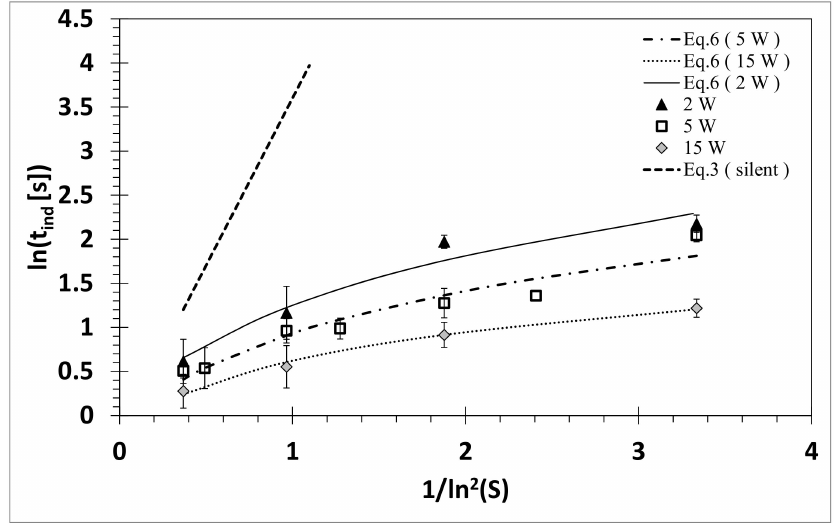
Figure 6. ln( t ind ) plotted as a function of 1/ln 2 ( S ) for 98 kHz at different ultrasound powers and the data were fitted with Equation (6). Equation (3) in Figure 2 for no ultrasound is inserted for